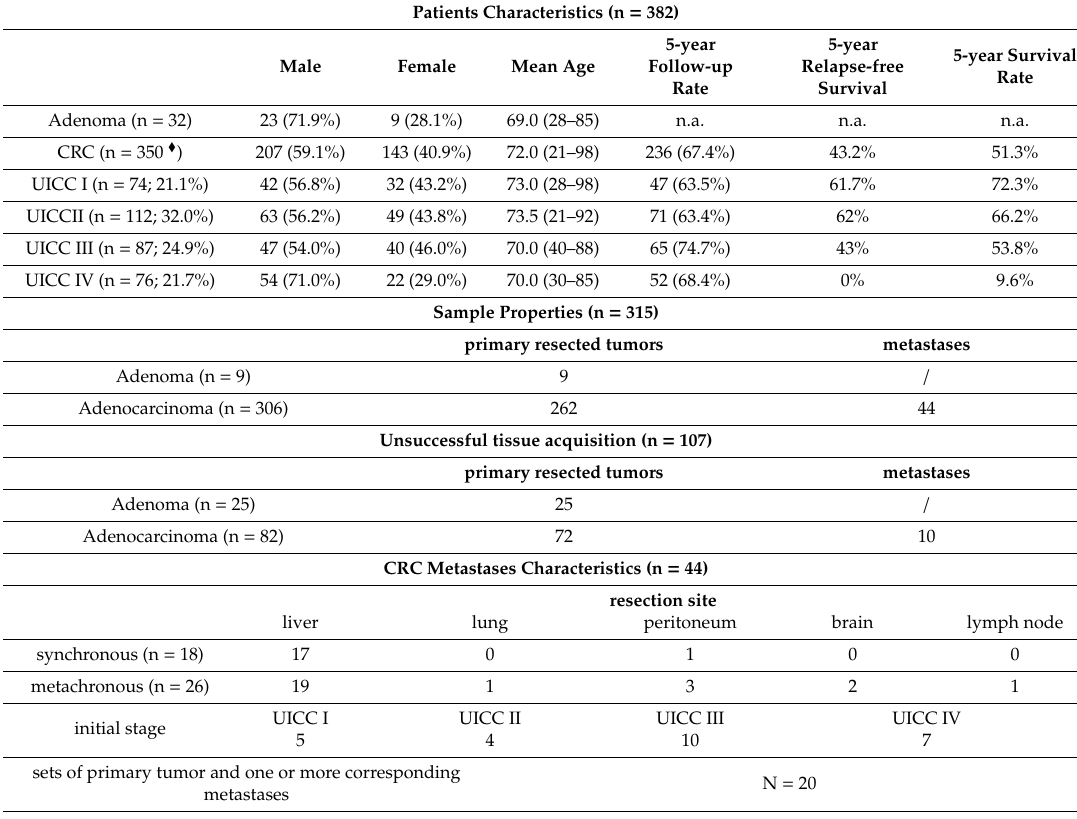
Table 1. Biobanking and patient